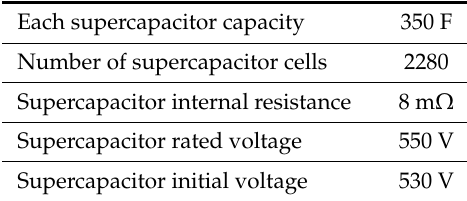
Figure 10. Supercapacitor based energy balancing system simulation waveform: ( a ) traditional version; ( b ) Improved version. Table 1. Parameters of the supercapacitor system.